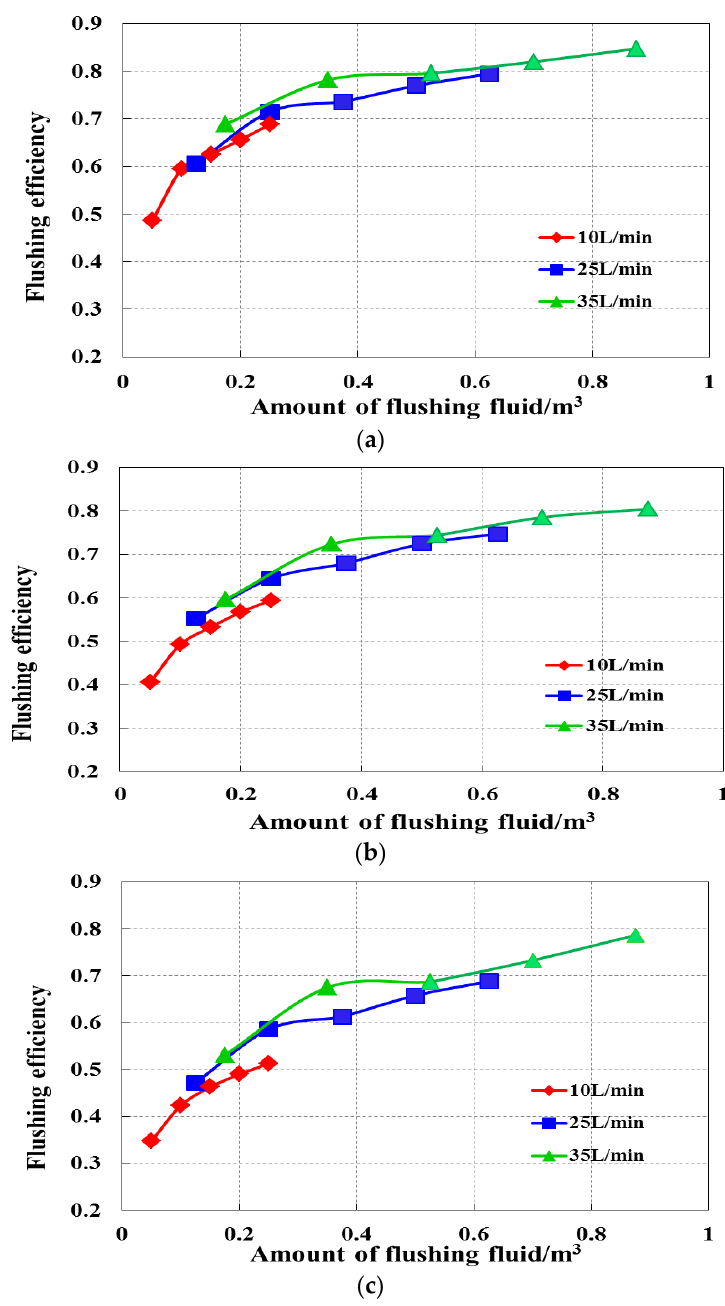
Figure 7. Variation of flushing fluid consumption and flushing efficiency of different cores under the condition of 10% flushing concentration ( a ) is ultra-low permeability core 0.1mD, ( b ) is medium permeability core A 10mD,( c ) is medium permeability core B 150mD. Table 2. Results of flushing efficiency under different flushing displacement and time.